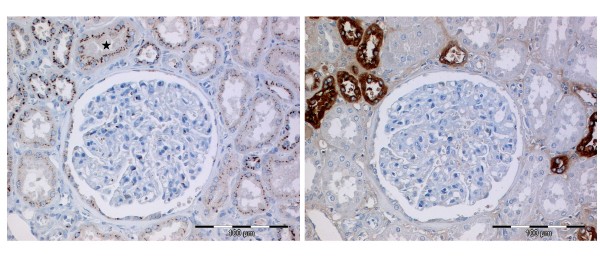
GOLPH2 immunohistochemistry in normal renal tissue. A/B GOLPH2 expression in normal renal tissue with the typical perinuclear granular staining pattern being more prominent in the distal tubules, although occasionally proximal tubules (star) were also strongly positive (A). Staining with Tamm-Horsfall protein in a subsequent tissue section validates the localization of GOLPH2 (B).